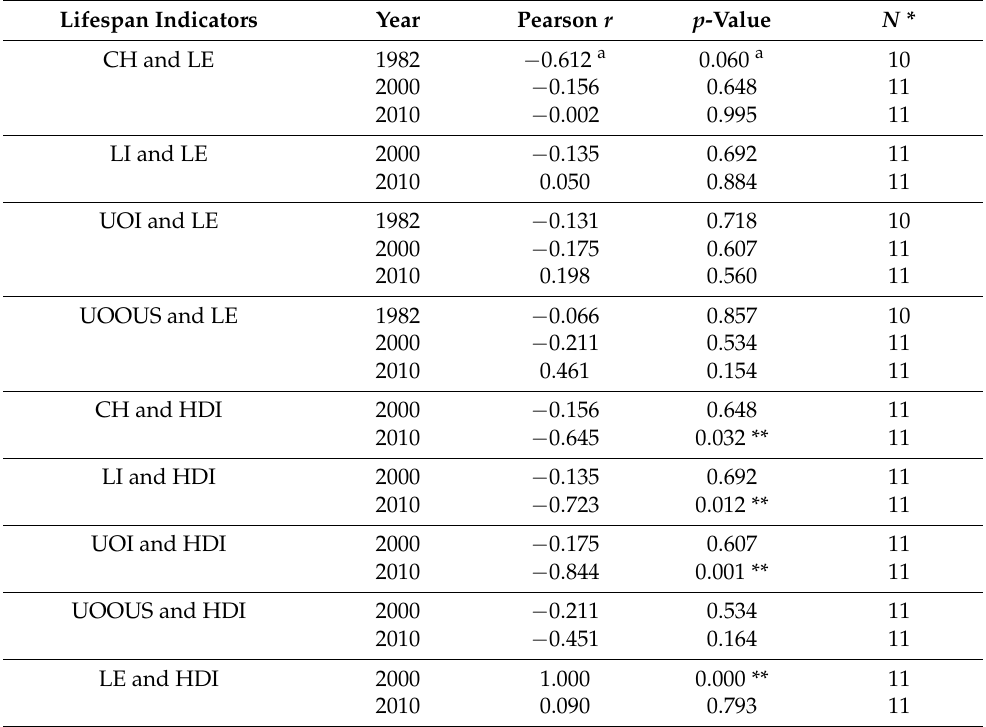
Table 2. Pearson correlation coefficients between longevity indicators and LE, as well as lifespan and Human Development Index